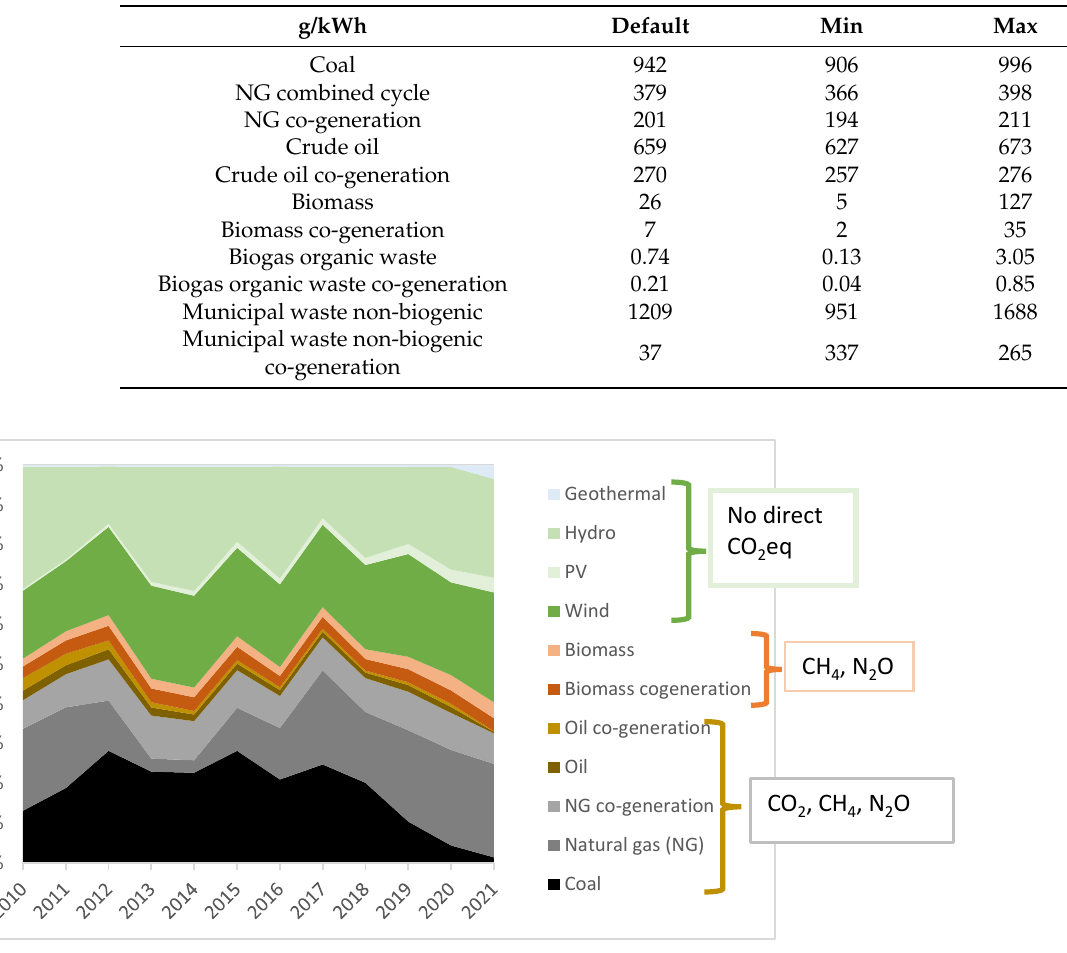
Figure 5. Portuguese electricity mix throughout the years, according to the Portuguese production. The GHG emission intensity can be retrieved from official databases; however, the IPCC equivalency factors are not up to date, and it is not clear if it concerns the direct emissions per gross kWh or net kWh, with or without co-generation, high, medium or low voltage. The in-house model allows using the most recent equivalency factors (with respective uncertainty) and also the intensity by technology and outputs the emission factor per gross kWh, according to the production mix. See the spreadsheet in the Supplementary Materials. The default value f elect = 274 gCO 2 eq/kWh for 2018 is used hereafter, which means that the e-bike electricity consumption of 12.1 Wh/km translates into 3.3 gCO 2 eq/km (12.1 × 10 − 3 × 274 = 3.3). The value for 2018 according to the APA [27] was 287 gCO 2 eq/kWh, and according to Eurostat, it was 310 g/kWh (see Figure 6). The effect of this variation is assessed in the results.